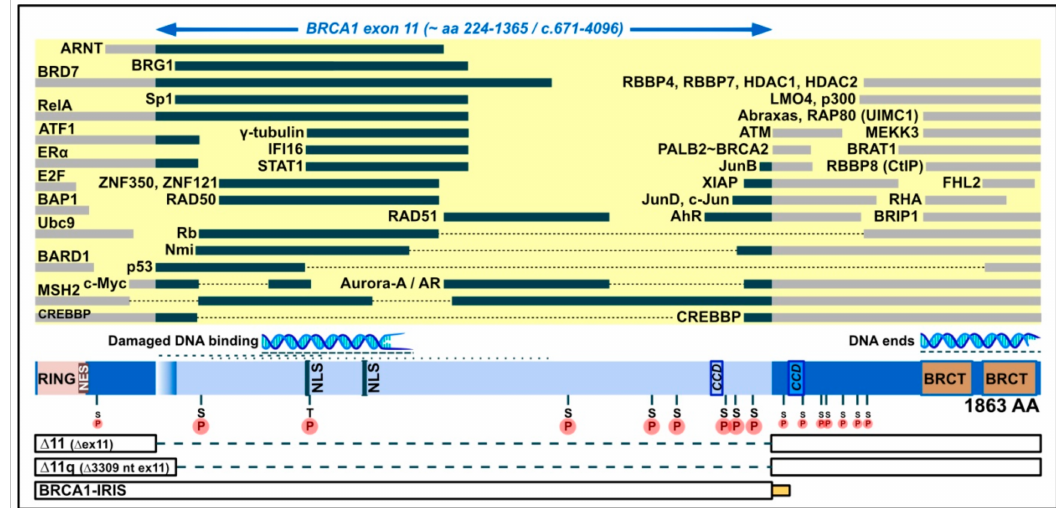
Figure 1. Domain map of the full-length BRCA1 protein (1863 amino acids), emphasizing its middle exon-11-derived region (light blue; bulged if included in ∆ 11q, but not ∆ 11 isoforms), which contains two nuclear localization signals (NLS), a coiled-coil domain (CCD), eight serine / threonine phosphorylation spots (pinned S or T on an encircled P), and binding positions for proteins (yellow area, black bars) and for damaged DNA. For comparison, indicated to the left and right of exon 11, are additional protein binding positions (yellow area, grey bars), a position of binding to DNA ends, further serine phosphorylation spots (smaller) and the following domains: RING (which binds, e.g., BARD1), NES (nuclear export signal), BRCT phosphopeptide recognition domains, and a CCD that mediates interaction with PALB2, which bridges to BRCA2. Below, in boxes, are the parts contained in smaller isoforms (connected by broken lines for skipped parts), with the intron-11-derived C-tail of BRCA1-IRIS (bottom) indicated by a small yellow / orange box (not present in full-length BRCA1 or other